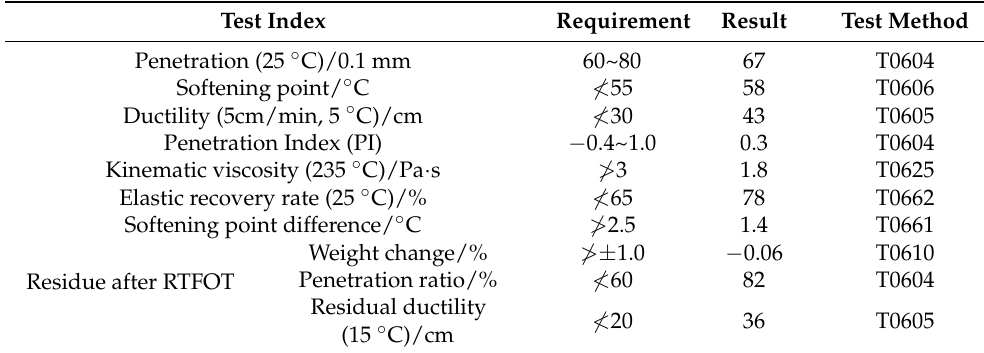
Table 3. Properties of SBS modified asphalt.